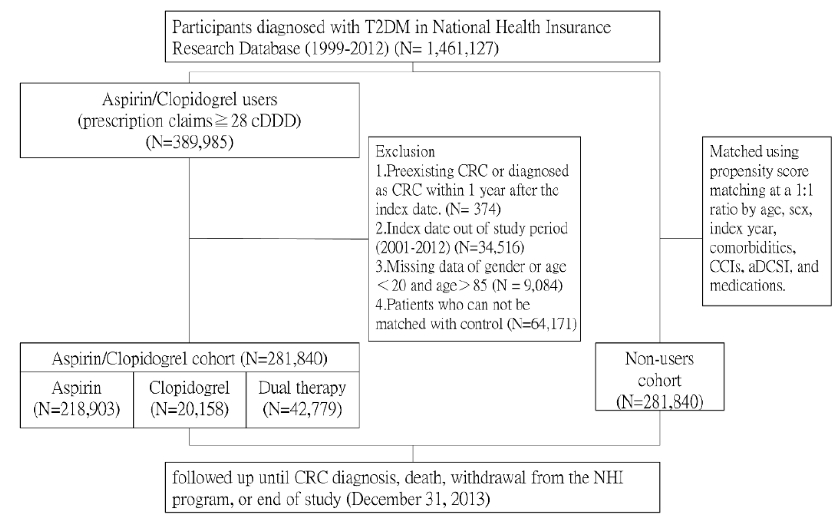
Figure 1. Flowchart of the current study.